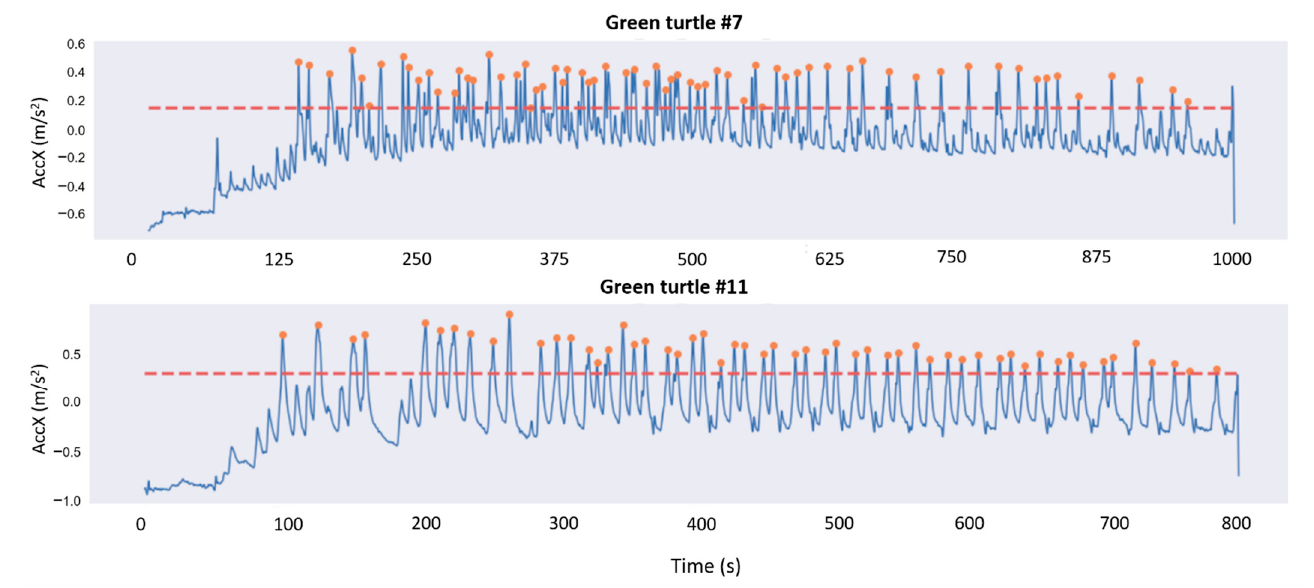
Figure 4. Visualization of the surge acceleration axis (back-to-front or X-axis, in blue) of the laying process of two green turtles with the peaks detected from a rolling window with width of 200.